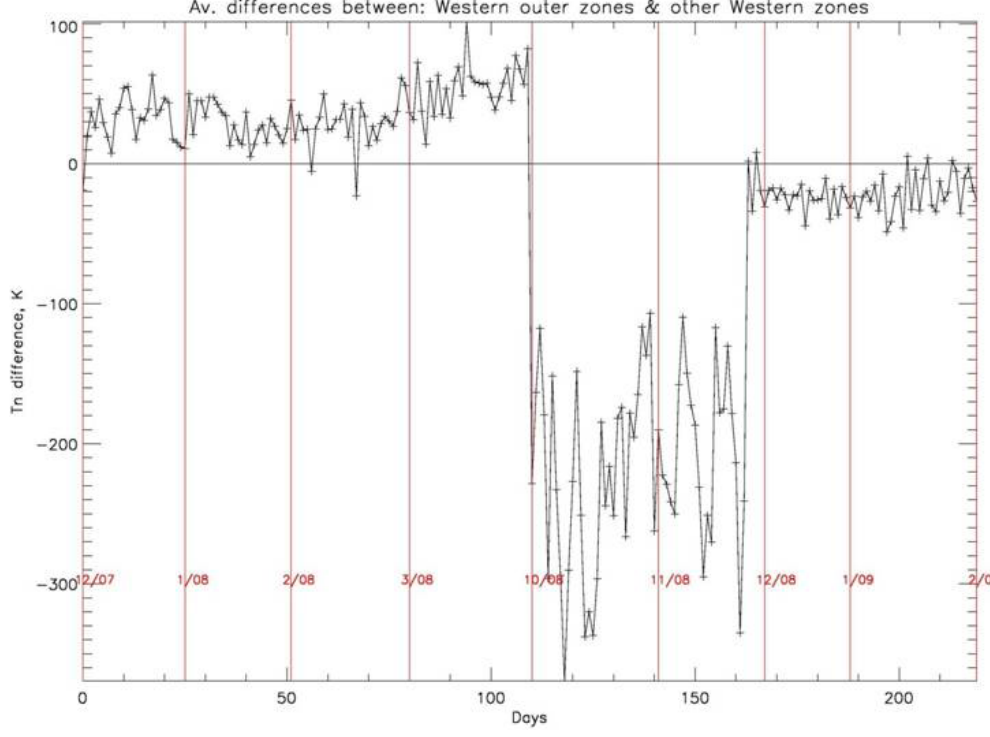
Fig. 12. Average offset of temperatures in ring 3 compared with temperatures in the inner rings for the West quarter